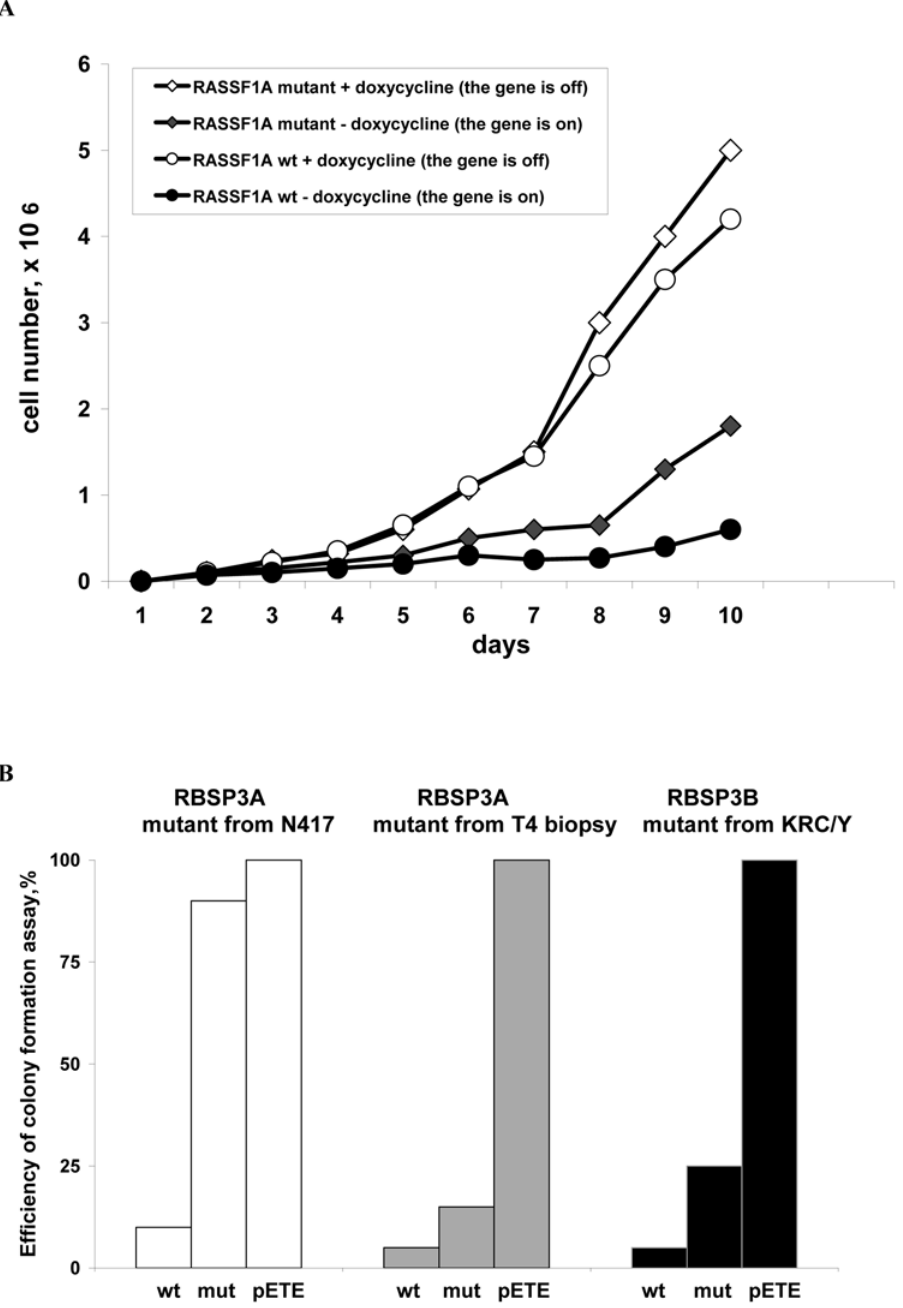
wt RASSF1A was 3 6 10 5 and the number of cells with mutant RASSF1A was 5 6 10 5 (1.7 times more than wt). On day 10, the number of cells with wt RASSF1A was 6 6 10 5 and the number of cells with mutant RASSF1A was 1.8 6 10 6 (3 times more than wt). The effect of expression of wild type and mutant RBSP3A and RBSP3B on colony formation efficiency in KRC/Y cells is shown in B. Mutants were isolated from the N417 SCLC cell line (His139Tyr), the ovarian tumor biopsy T4 (three mutations: Asn31Asp, Pro79Ser and Glu87Lys) and the KRC/Y cell line (three mutations: Lys35Met, Asp103Gly and Leu181Pro). The number of blasticidin-resistant colonies compared to the empty pETE were: 90% for mutant from N417, 15% for mutant from T4 biopsy and 25% for mutant from KRC/Y. The number of colonies for wtRBSP3A were 5–10% compared to the pETE